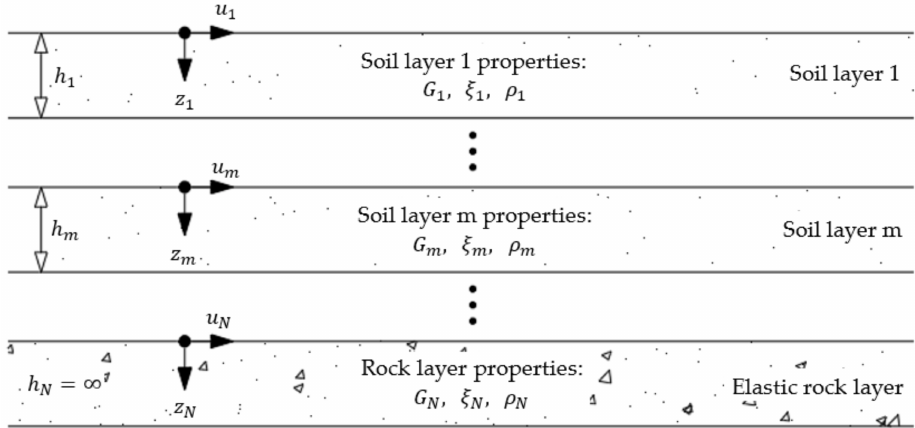
Figure 11. 1D model and the transfer function F 2 ( ω ) for a layered